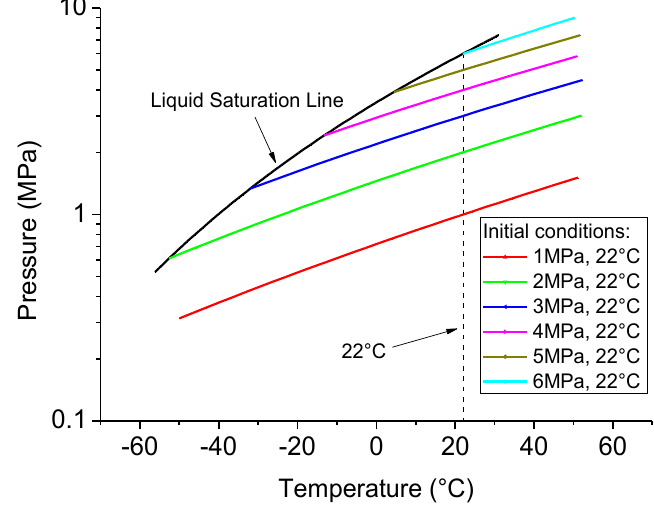
Figure 17. Isentropic plots of pure CO 2 for different initial conditions (date were obtained from REFPROP Database [38]).